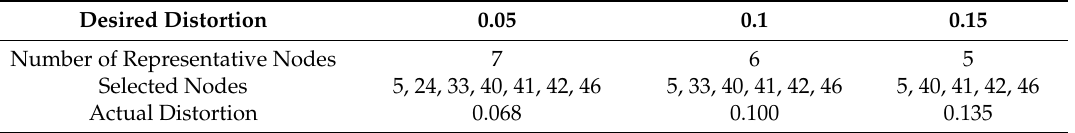
Table 11. The selection of representative nodes and the actual distortion based on a theoretical calculation (dataset 2 with N = 10 nodes).